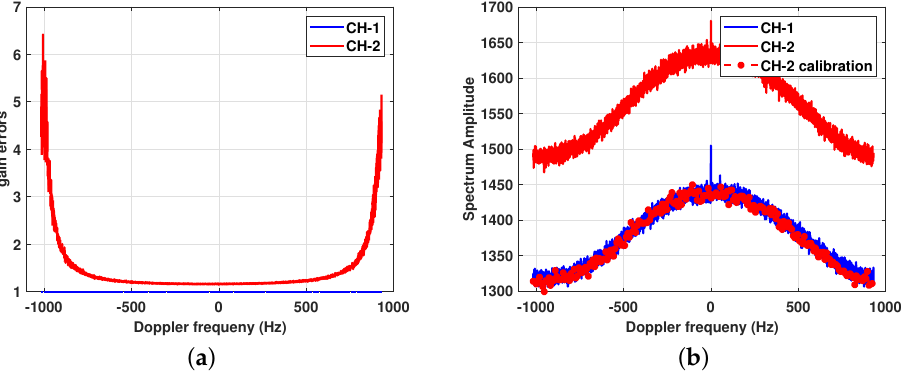
Figure 11. The channel gain error and the azimuth spectrum of GF − 3 dual − channel mode. ( a ) Esti- mated result using the proposed method. ( b ) The azimuth spectrum of each channel signal, where the red and blue lines correspond to the CH-1 and CH-2 before gain error calibration, respectively, while the red • corresponds to CH-2 after gain error